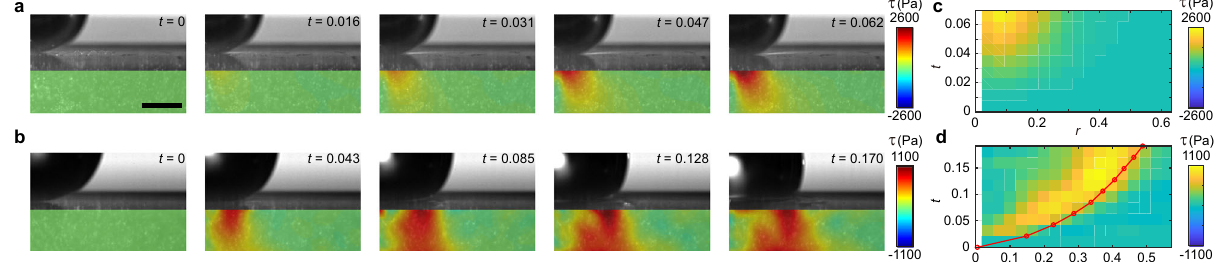
Fig. 3 Shear stress distribution of solid-sphere impact and drop impact. a , c The temporal evolution of the shear stress τ ( r , z , t ) and the kymograph of the surface shear stress τ ( r , z = 0, t ) of solid-sphere impact. The diameter and the impact velocity of the steel sphere are D = 3.16 mm and U = 0.49 m/s, respectively. b , d The temporal evolution of τ ( r , z , t ) and the kymograph of τ ( r , z = 0, t ) of drop impact. D = 3.49 mm and U = 2.97 m/s for the liquid drop. The red line in ( d ) indicates the position of the turning point. t = 0 corresponds to the instant when the impactors fi rst touch the surface of the PDMS gels. Scale bar in ( a ) is 1 mm.